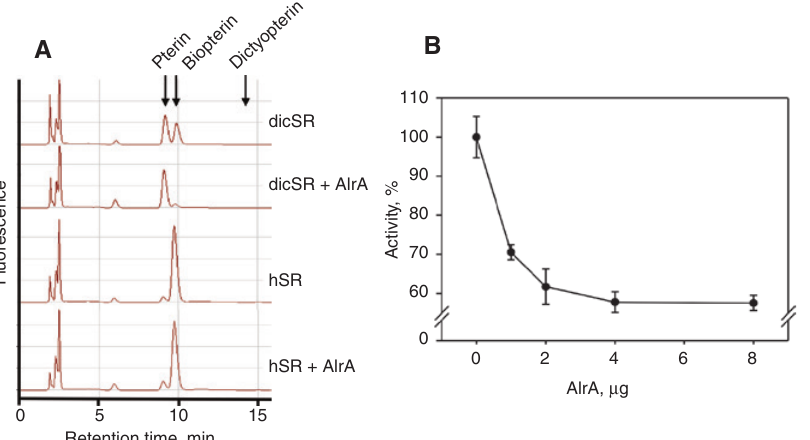
Figure 4: In vitro assay of the recombinant AlrA. dicSR and hSR were incubated alone or co-incubated with AlrA. Equal amounts of proteins (2 μ g each) were used for the assay. (A) The reac- tion mixtures analyzed by HPLC after acidic iodine oxidation. (B) BH4 production in the co-incubation assay where a fixed amount (2 μ g) of dicSR or human SR was